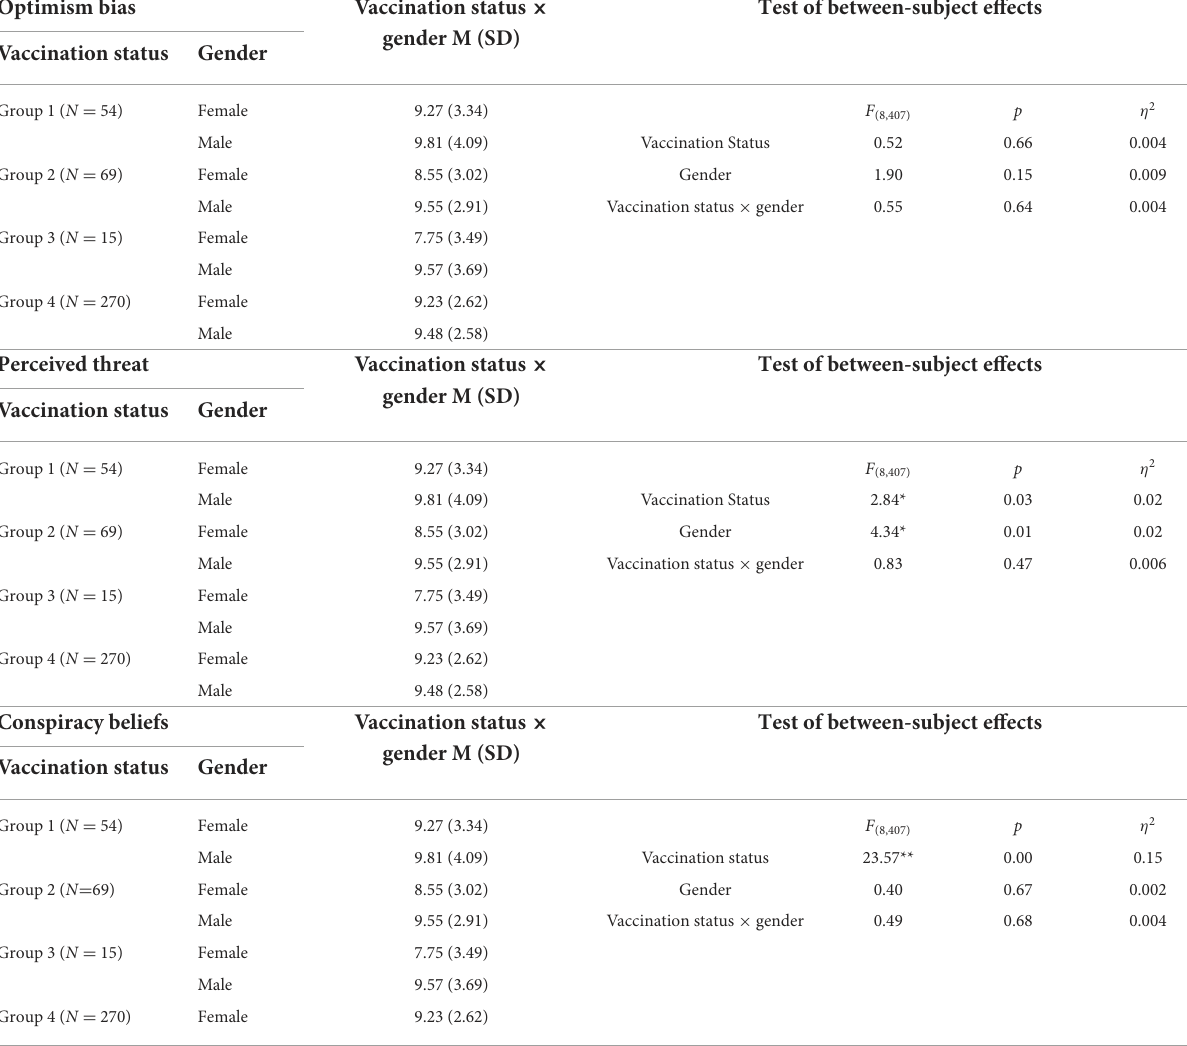
TABLE 3 Univariate ANOVA test results for optimism bias, perceived threat, and conspiracy beliefs (vaccination status × gender). Optimism bias Vaccination status × gender M